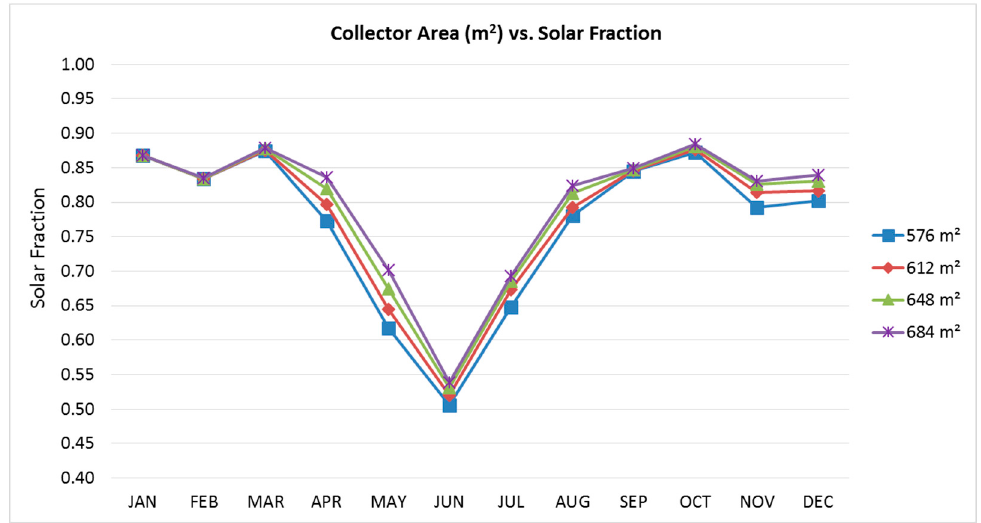
Figure 9. The impact of the solar collector area on solar fraction.